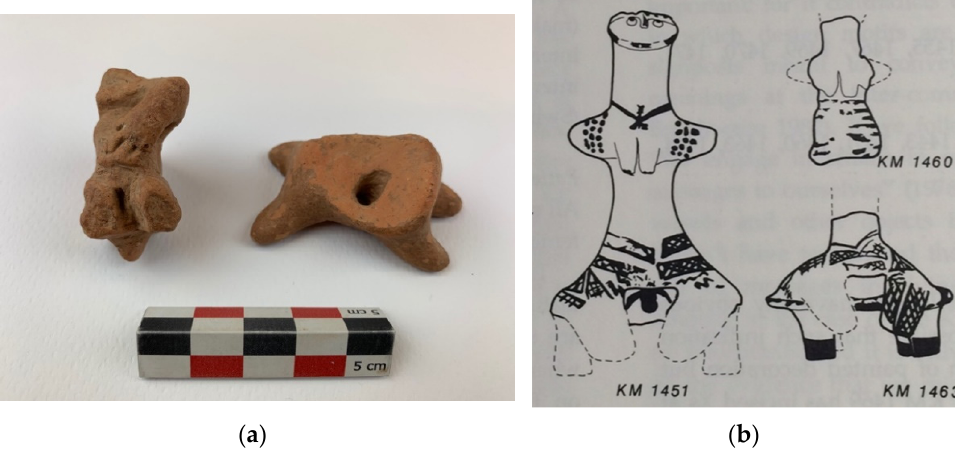
Figure 1. ( a ) Fragmentary clay figurine of a birthing female with a dilated vulva and a hand on the belly, originally seated on a stool like the one adjacent. Petsophas. Crete, 2000–1600 BCE. Archaeological Museum of Agios Nikolaos, Crete. ( b ) Drawing of clay parturient figurines—one with an emerging infant—seated on stools. Kissonerga-Mosphilia. Cyprus, c. 3000 BCE. Courtesy of Diane Bolger.